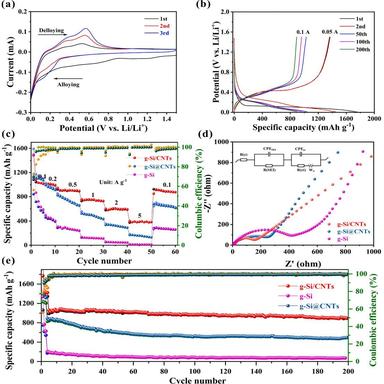
(a) Cyclic voltammertry curves and (b) Charging/discharging curves of the g-Si/CNTs composites; (c) Rate curves of g-Si, g-Si@CNTs, and g-Si/CNTs composite; (d) Nyquist plots of g-Si, g-Si@CNTs, and g-Si/CNTs composite after the 1st cycle with the inset showing the fitted equivalent circuit; (e) Cycling curves of the g-Si/CNT composite at 0.1 A g− 1 .